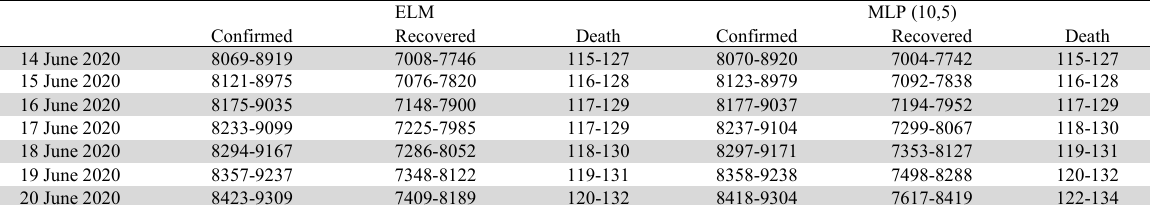
The forecasting results of ELM and MLP models